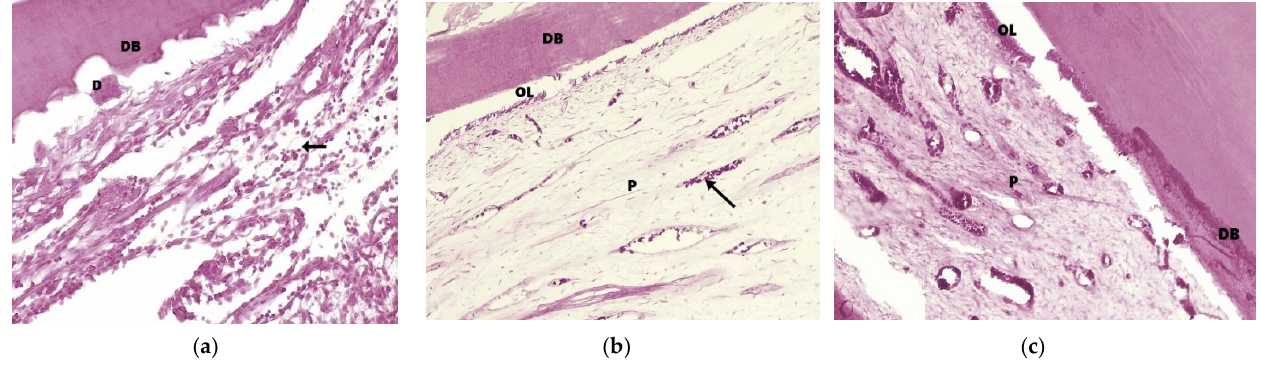
Figure 7. Dental pulp of dog primary teeth capped with different biomaterials (HE coloration): ( a ) CH– arrow = marked acute and chronic severe pulpal inflammation; D = dentin flakes; DB = dentinal bridge (100× magnification). ( b ) MTA— p = normal pulp tissue; arrow = minimal inflammatory reaction; hyperemic blood vessels; DB = dentinal bridge; OL = odontoblastic layer (100 × magnification). ( c ) Biodentine TM — p = normal pulp tissue; DB = dentinal bridge; OL = odontoblastic layer (200 × magnification).